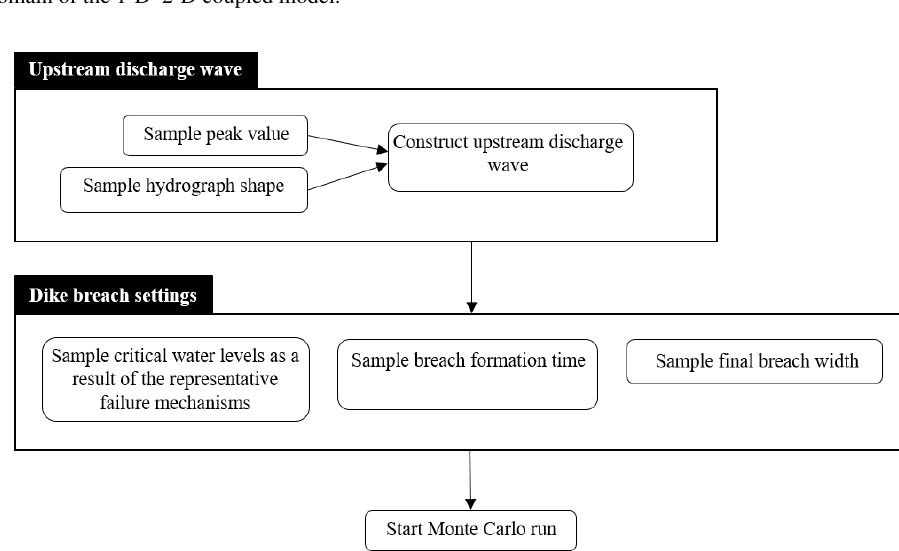
Figure 3. Random input parameters considered in the Monte Carlo